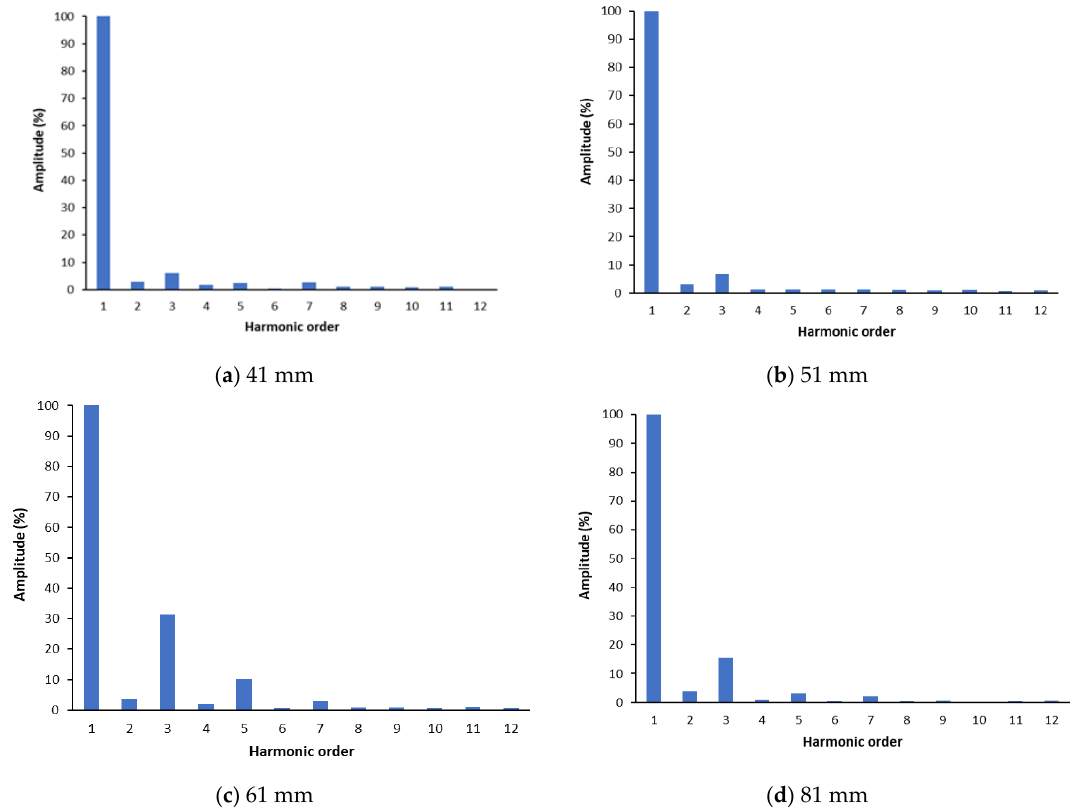
the stress grading system at ( a ) 41 mm, ( b ) 51 mm, ( c ) 61 mm, and ( d ) 81 mm. Energies 2019 , 12 , x FOR PEER REVIEW